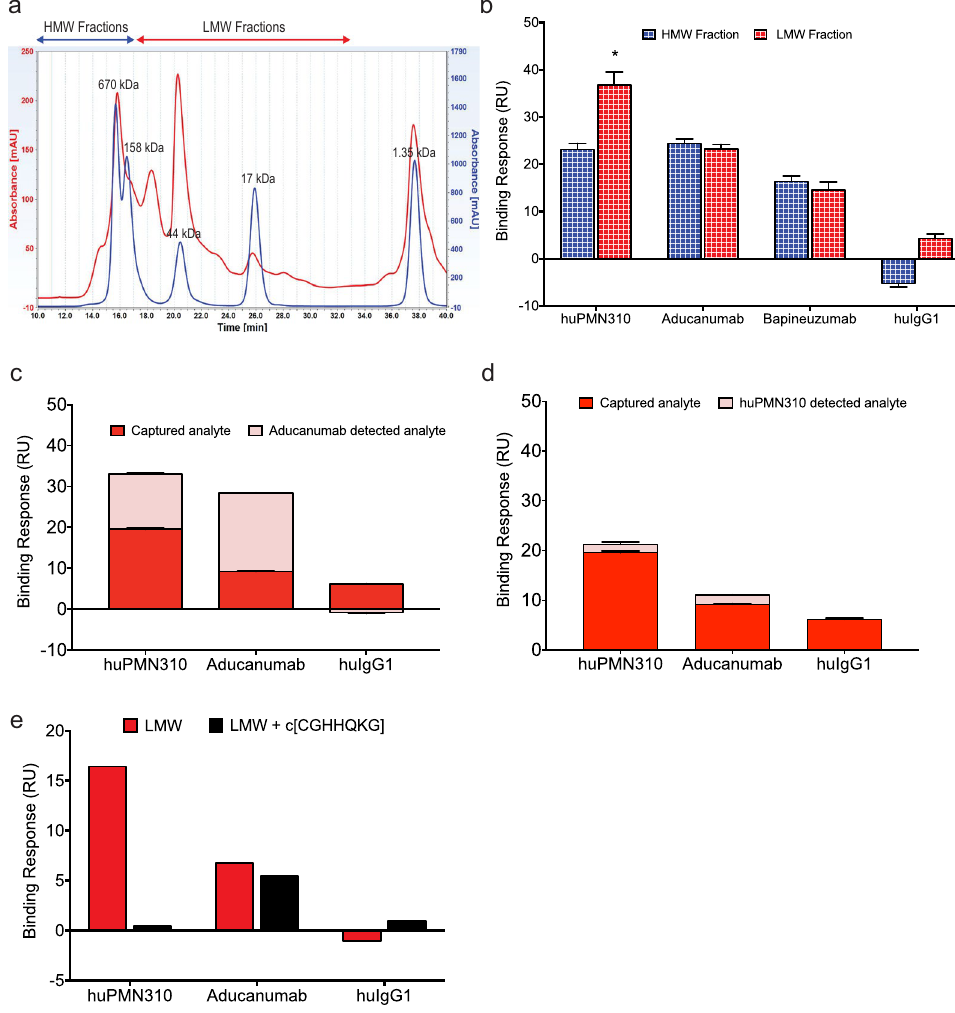
Figure 6. huPMN310 selectively recognizes soluble, low molecular weight, A β aggregate species in AD brains. ( a ) SEC fractionation chromatogram of pooled soluble AD human brain extracts. A representative chromatogram from 9 independent fractionations is shown (red line). MW markers are superimposed for reference (blue line). ( b ) SPR binding response of indicated antibodies to pooled LMW and HMW fractions. Four measurements were made under identical conditions: statistical significance of differences was determined by two-way ANOVA with Sidak’s multiple comparison test: LMW binding by huPMN310 was greater than all other measurements (p < 0.0001), huIgG1 (LMW and HMW) binding was significantly less than all other measurements (p ≤ 0.0012). No significant difference between LMW and HMW binding for aducanumab vs bapineuzumab. ( c , d ) SPR binding response of indicated antibodies to LMW AD brain extract and subsequent aducanumab ( c ) or huPMN310 ( d ) detection of the analyte captured. Fifteen capture and three detection measurements under identical conditions were performed. ( e ) c[CGHHQKG] peptide was pre-injected over indicated immobilized antibody surfaces to compete with LMW brain analyte. Data are representative of two experiments with similar results.